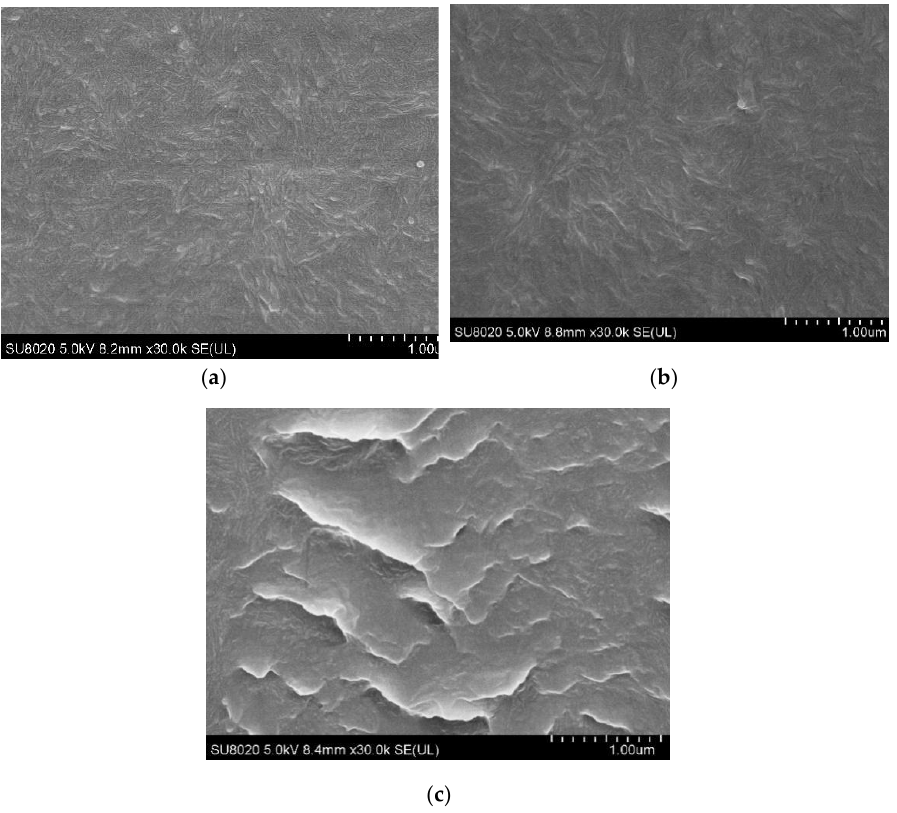
Figure 5. SEM crystalline textures of fractured XLPE ( a ) cable body, ( b ) recovery insulation and ( c ) interface